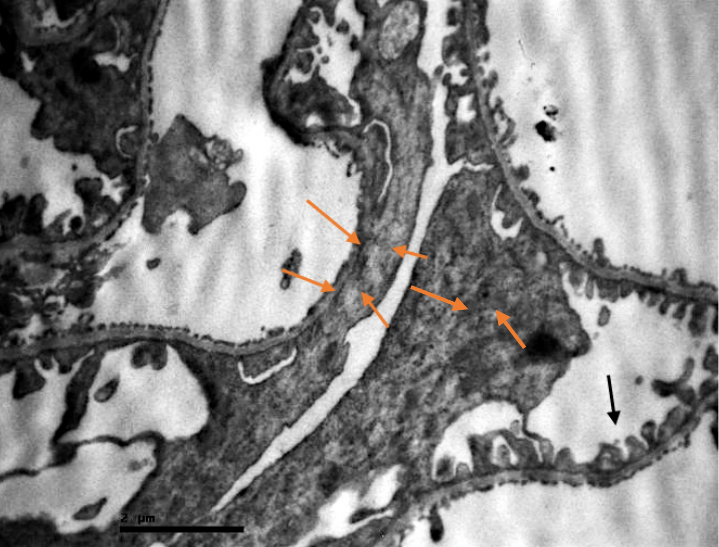
Figure 5. Renal corpuscle of resuscitated swine sample. Fusion of the podocytes (orange arrows). Relatively normal podocytes, not entirely separated as they should normally be (black arrow).